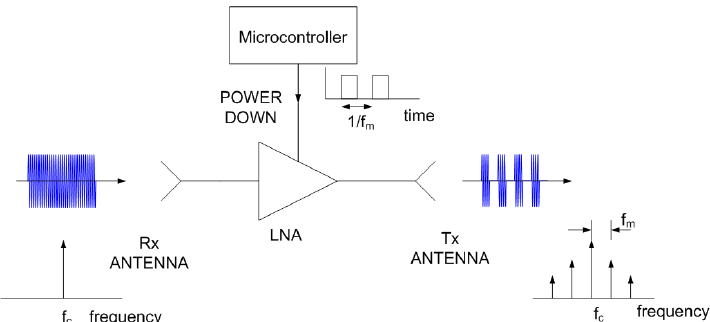
Figure 5. Block diagram of a modulated backscatter based on an amplifier. FMCW radar uses a range–Doppler (RD) map to simultaneously detect the range and velocity of the targets [56] obtained from the samples of several chirps grouped in a frame (see Figure 6). Each frame is composed of L chirps with N samples per chirp sampled at a rate of f s = 1/ T s . The complex representations ( s [ n ] = I [ n ] + jQ [ n ] ) are saved in a matrix s so that the columns correspond to the samples for each chirp